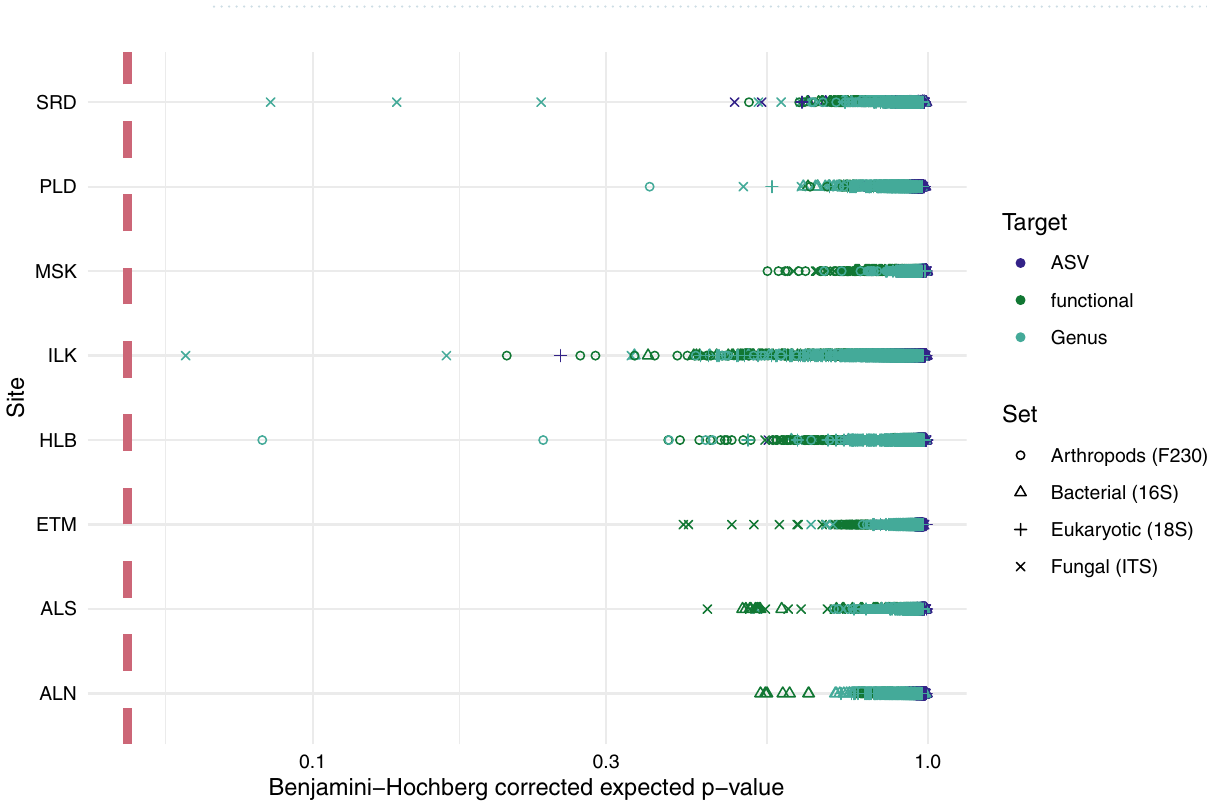
Figure 5. Proportion of variance explained by RDA axes constrained by the ash amendment parameters of applied calcium kg ha −1 , applied phosphorus kg ha −1 , and, applied sodium kg ha −1 , after controlling for site and soil horizon. Model names are described as the targeted gene (16S, 18S, ITS, or, F230), summarization level (ASV, genus, or functional groupings).